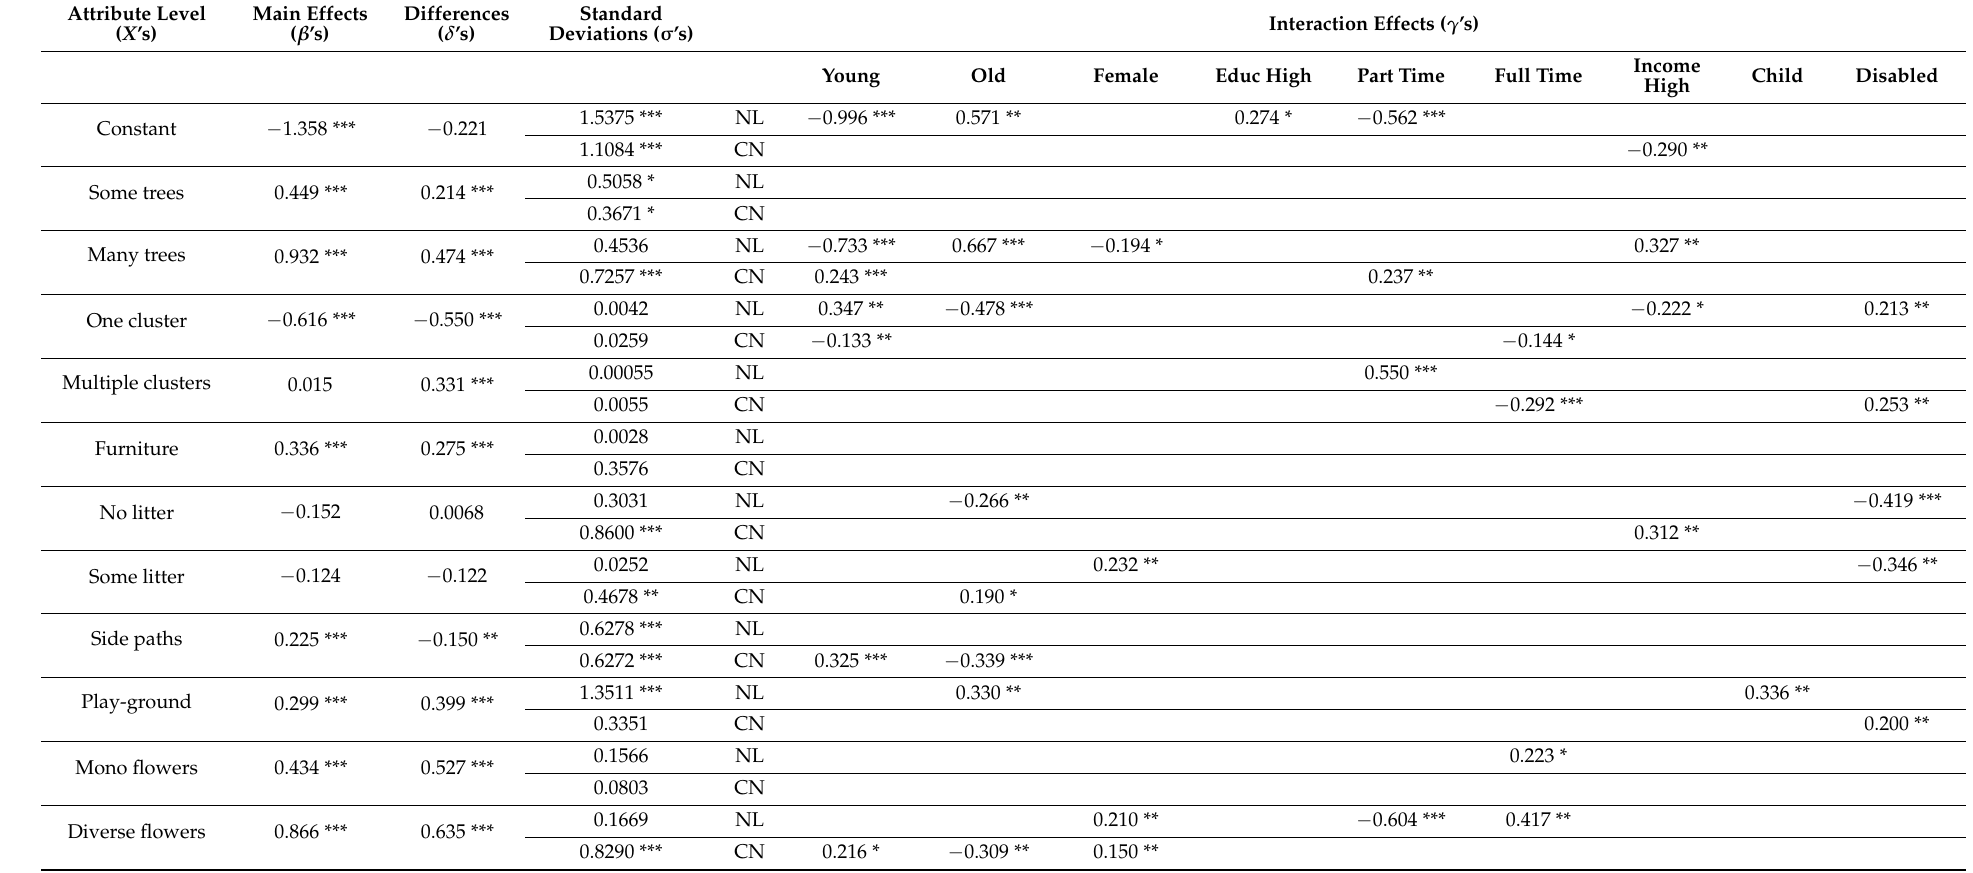
Table 5. Results of the random parameter mixed multinomial logit